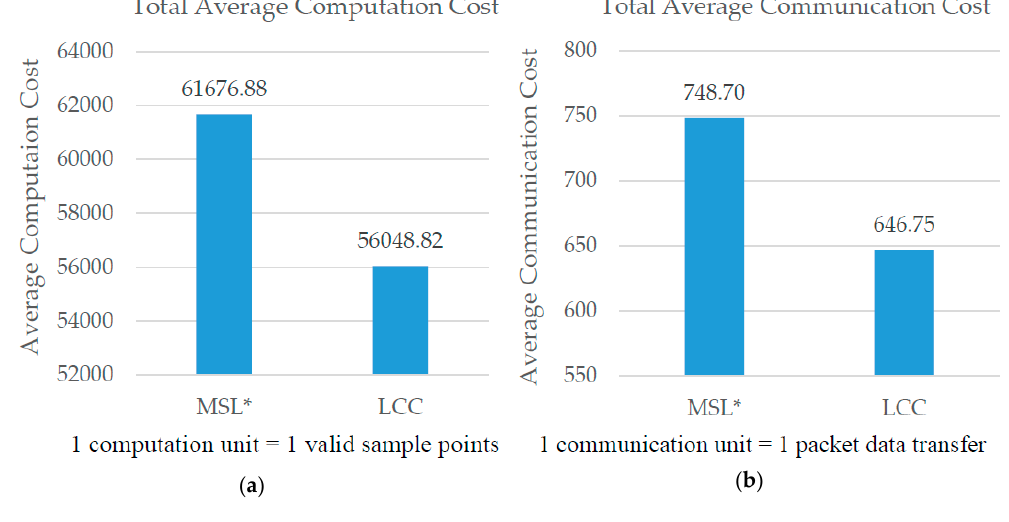
Figure 1 . ( a ) Average computation cost of MSL* and LCC. ( b ) Average communication cost of MSL* and LCC.